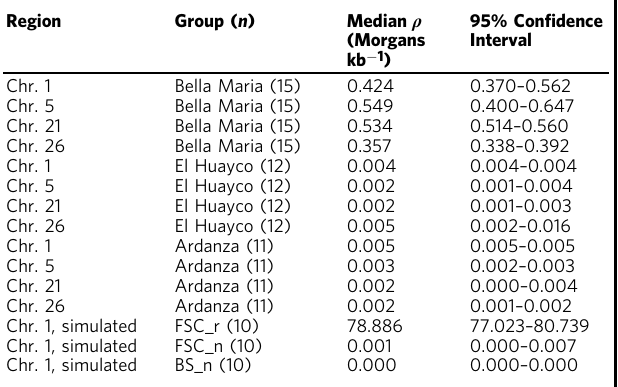
Table 2 Composite-likelihood approximation of the population recombination parameter ρ Region